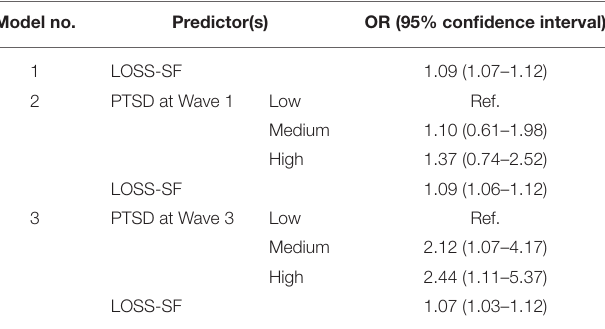
TABLE 2 | PTSD and Late Onset Stress Symptomatology (LOSS-SF) scores as predictors of whether military experience affected coping with COVID. Model no.